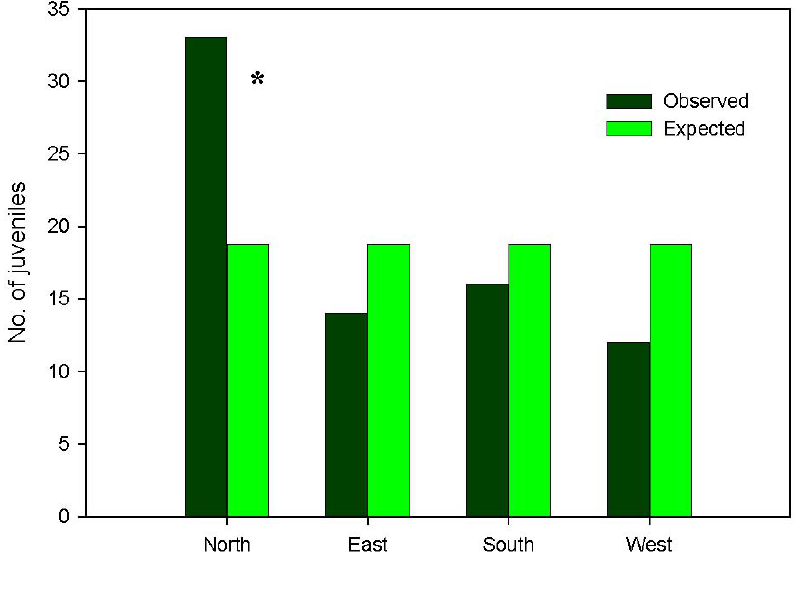
Figure 5. Observed and expected aspect orientation of Pinus nigra saplings with respect to nearest Juniperus communis shrubs. * indicates significant differences (p <